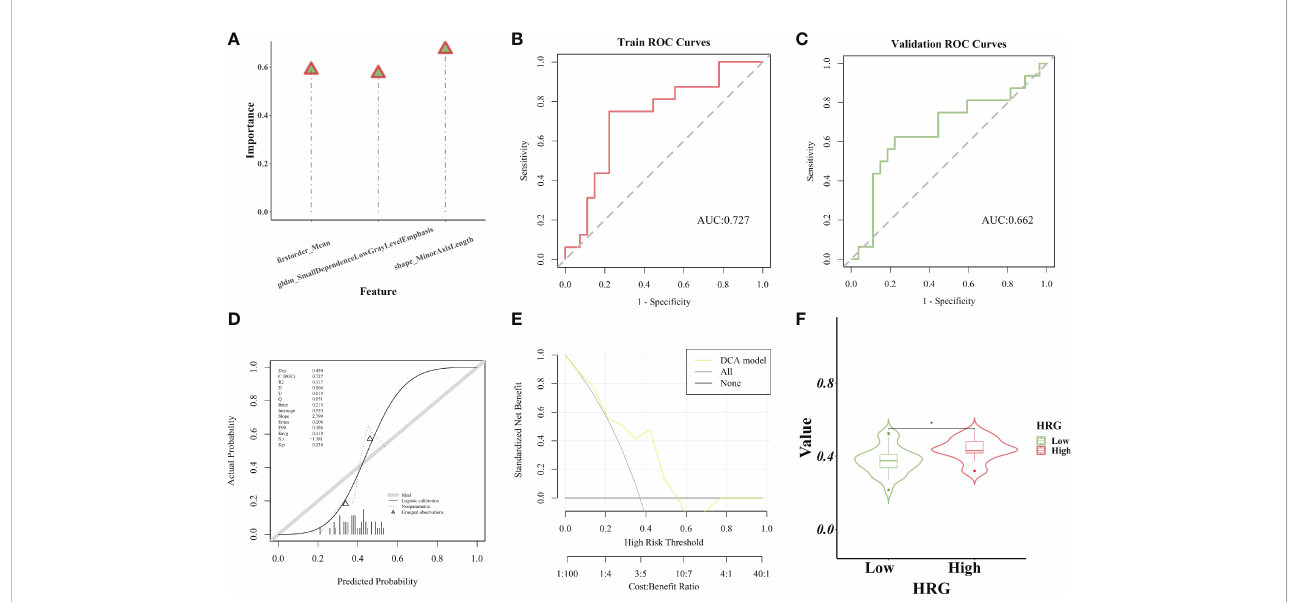
FIGURE 7 Establishment and evaluation of the SVM model. (A) . The importance of screened features in SVM algorithm; (B) . The model ’ s AUC value in the training set; (C) . The AUC value of the model in the veri fi cation set; (D) . The calibration curve displays the probability of high HRG expression; (E) . DCA curve displays high clinical practicability of the model; (F) .Rad_score was higher in HRG high expression group. * represent p <